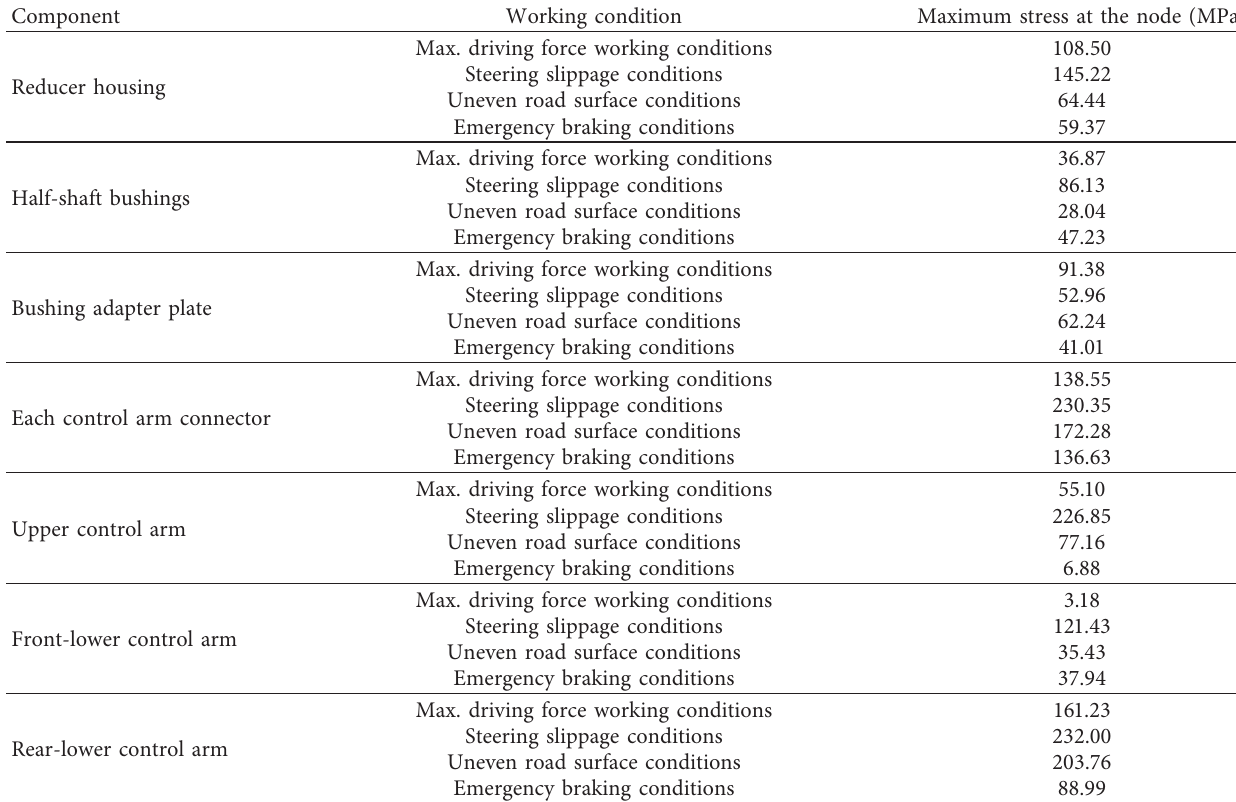
Table 16: Maximum stress on each component node under different working